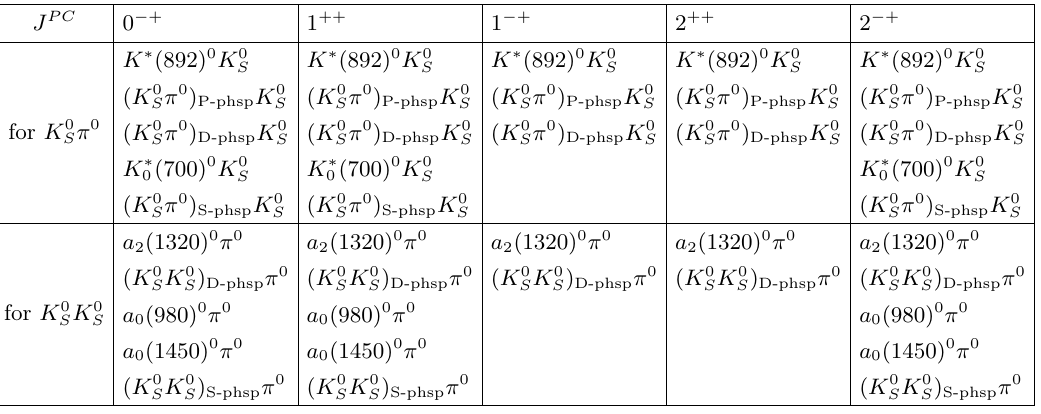
Table 1 . The set of all possible decay mode candidates evaluated in the MI